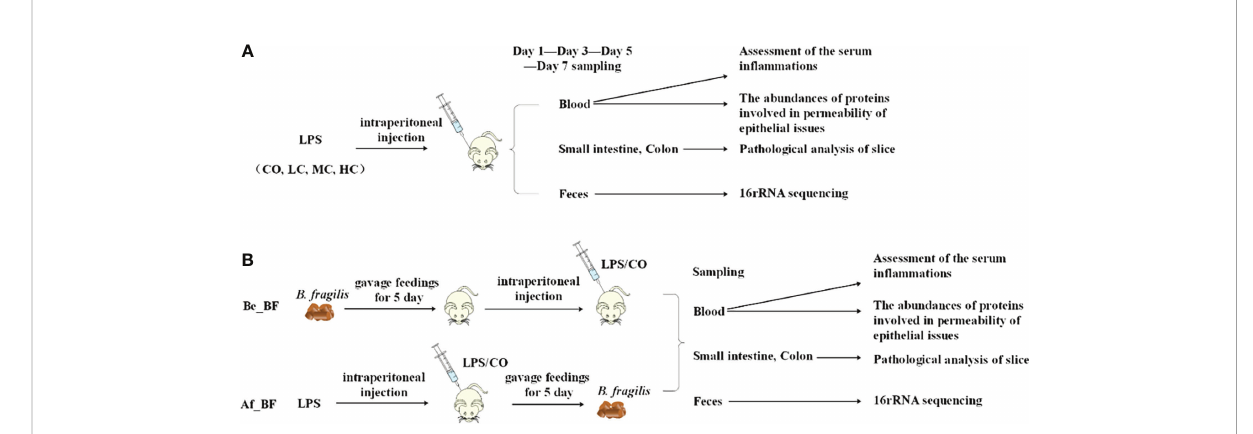
FIGURE 1 Protocol of invasion assay. (A) Rats ( n = 4) were infected with LPS at densities of 0 EU/kg (CO), 2 × 10 7 EU/kg (LC), 3 × 10 7 EU/kg (MC), and 4 × 10 7 EU/kg (HC), respectively. The blood, small intestine, colon, and feces were collected to assess the effects after injection of LPS for 1, 3, 5, and 7 days. (B) Continuous gavage feedings of B . fragilis NCTC9343 were performed for 5 days on SD young rats ( n = 4). Be_BF, B . fragilis treatment before injection of LPS; Af_BF, B . fragilis treatment after injection of